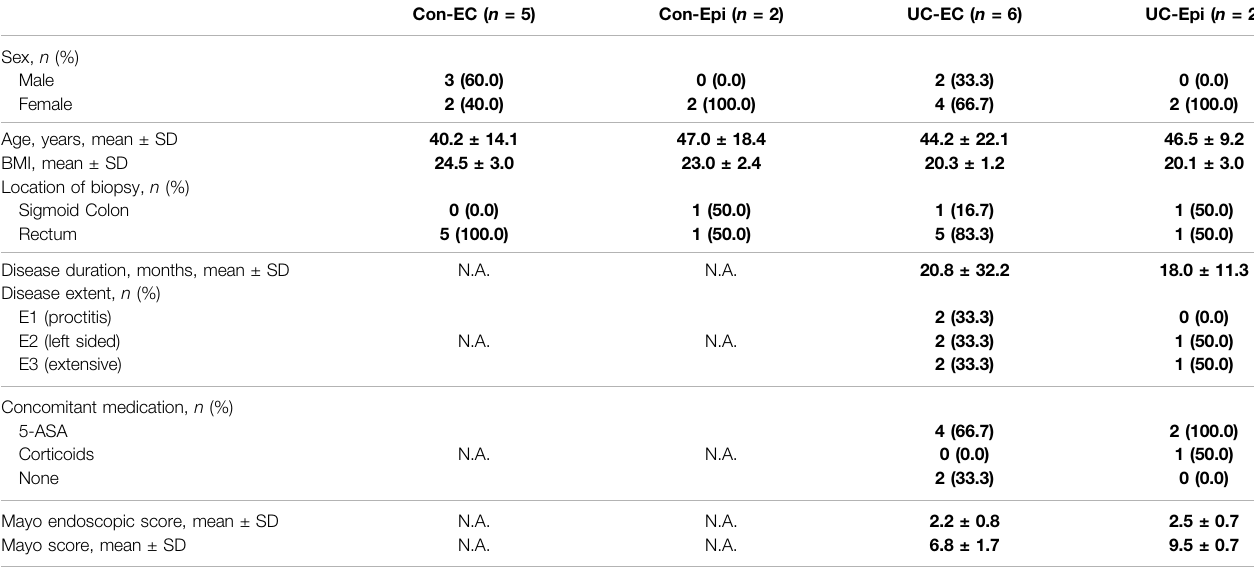
TABLE 1 | Demographic and clinical characteristics of the participants in each